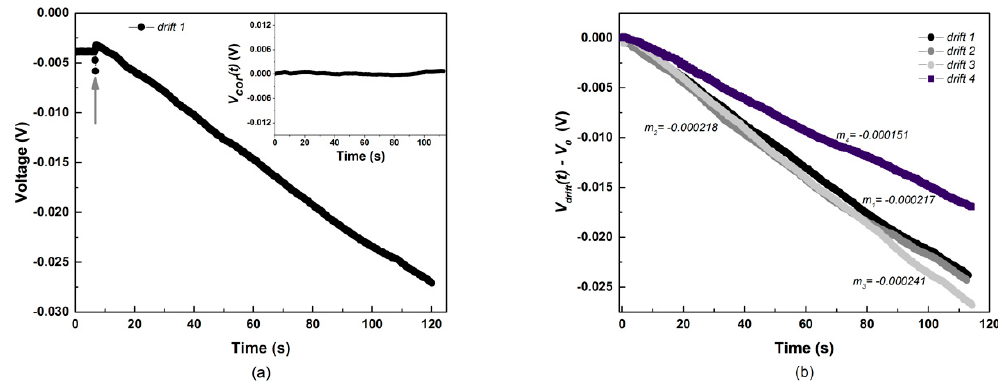
Figure 3. Drifts measurements with piezoelectric sensor PS 1 in an empty slit. ( a ) Time dependence of the voltage delivered by the charge amplifier. The arrow indicates the time at which the amplifier is switched on. The inset in (a) displays the corrected voltage V cor (t) . ( b ) Reproducibility of the slope of the drift V drift (t) − V 0 .